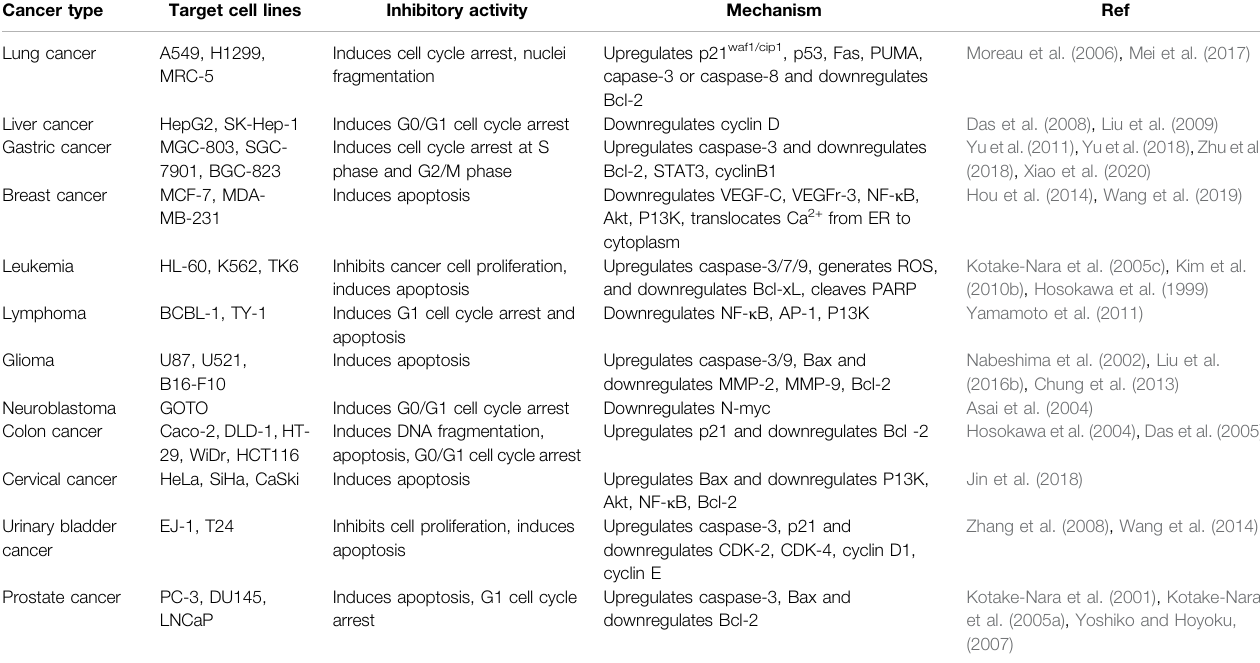
TABLE 4 | Inhibitory effect of FX on different cancer types and its underlying